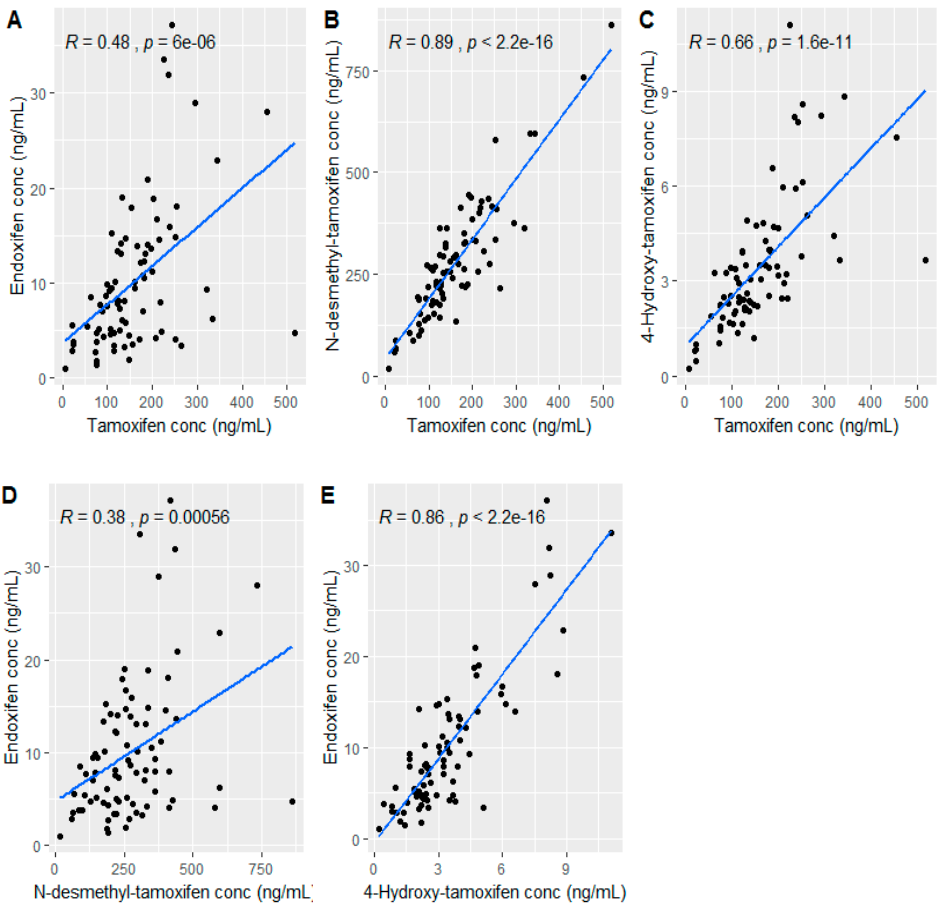
Figure 1. Scatter plot showing the Pearson’s correlation between endoxifen versus tamoxifen ( A ), N-desmethyl-tamoxifen versus tamoxifen ( B ) and 4-hydroxy-tamoxifen versus tamoxifen ( C ), endoxifen versus N-desmethyl-tamoxifen ( D ) and endoxifen versus 4-hydroxy-tamoxifen ( E ).